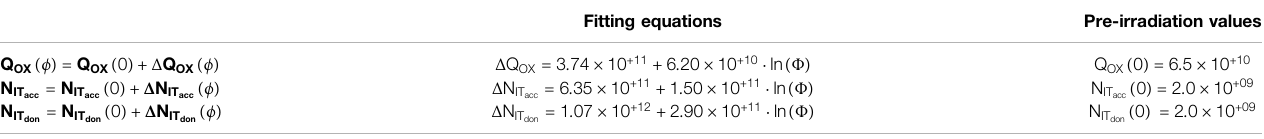
TABLE 2 | Fitting equations and pre-irradiation values for “ Perugia 2019 Surface ” modeling HPK silicon devices: oxide charge Q OX (cm − 2 ), acceptor interface trap states N ITacc (cm − 2 ), donor interface trap states N ITdon (cm − 2 ). Fitting equations Pre-irradiation values